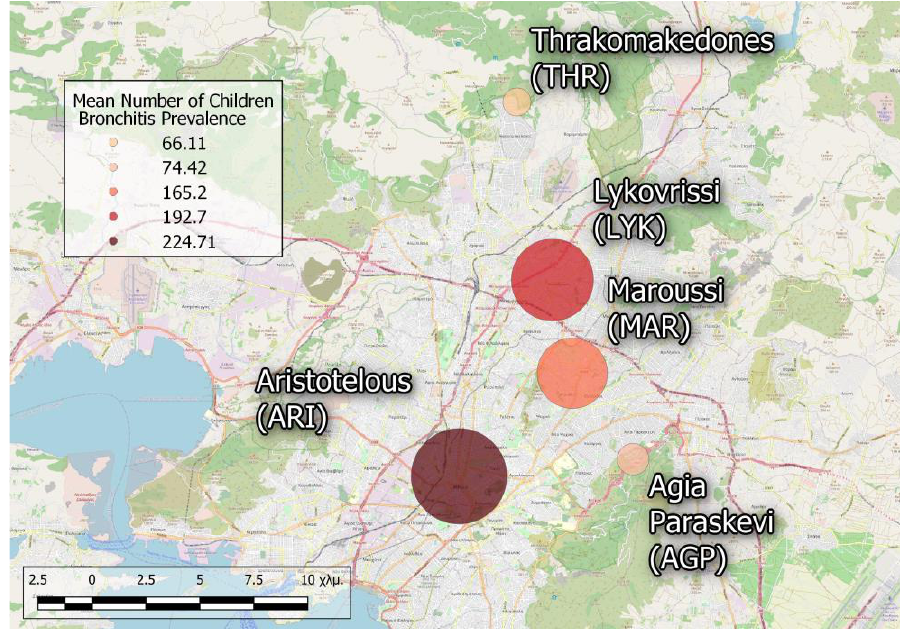
Figure 9. Spatial distribution of childhood bronchitis prevalence during the period 2001 – 2020, based on the population of each location. (Satellite image by ESRI).